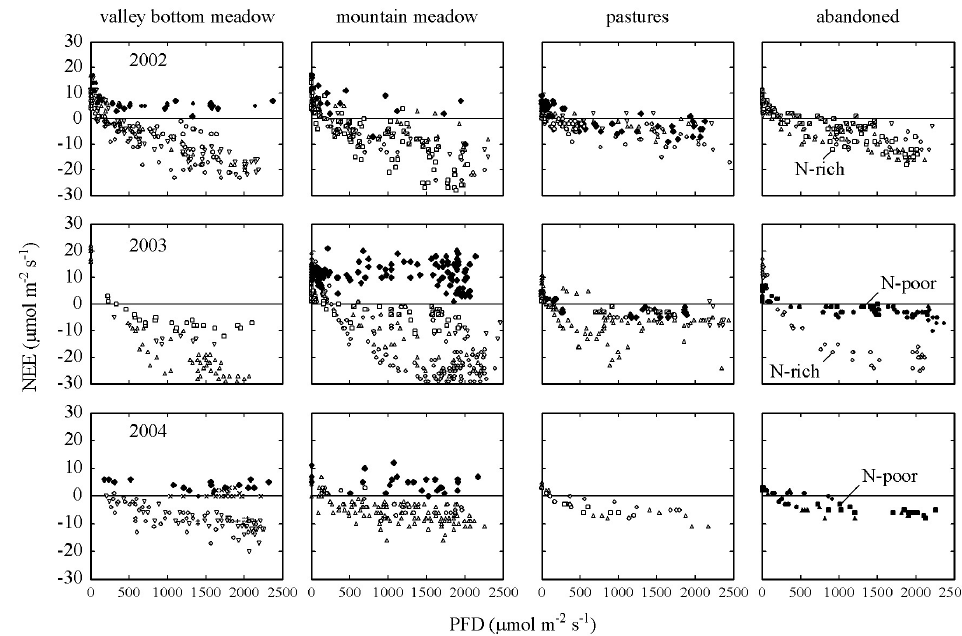
Fig. 2. NEE in relation to photon flux density (PFD) for two meadows, two pastures and two abandoned grasslands during the growing seasons 2002–2004. Negative values denote net CO 2 uptake by the canopy, positive values a net loss of CO 2 to the atmosphere. Each data point shows a single set of chamber measurements. The measurements were taken during clear days. The following symbols are used: × March, + April, ∇ May, ♦ June, M July, (cid:3) August, m September, October, November; closed symbols indicate NEE after mowing and grazing on the meadows at the valley bottom (1000m) and the mountain slope (1850m), as well as the pastures. For the abandoned sites open and closed symbols indicate values for the nutrient-rich and the nutrient-poor abandoned grassland, respectively.